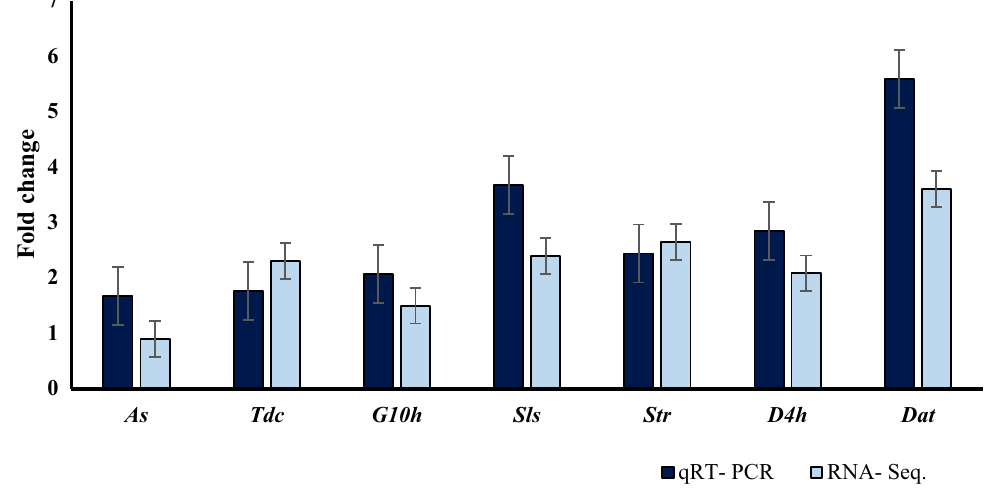
Figure 5. Comparison of qRT-PCR 27 and RNA-Seq of Tdc , G10h , Sls , Str , D4h and Dat genes in 24-h treatment.